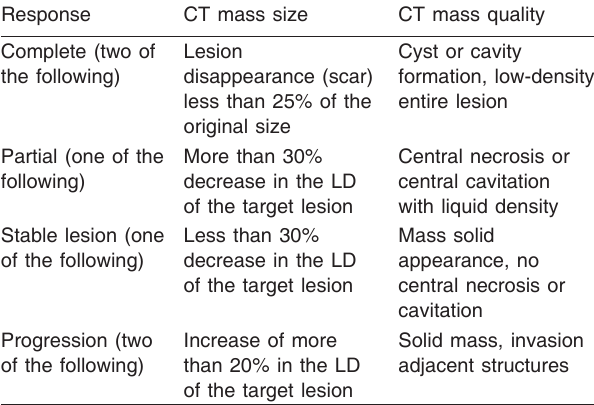
Table 1 Modified RECIST criteria for evaluation of treatment response [13]